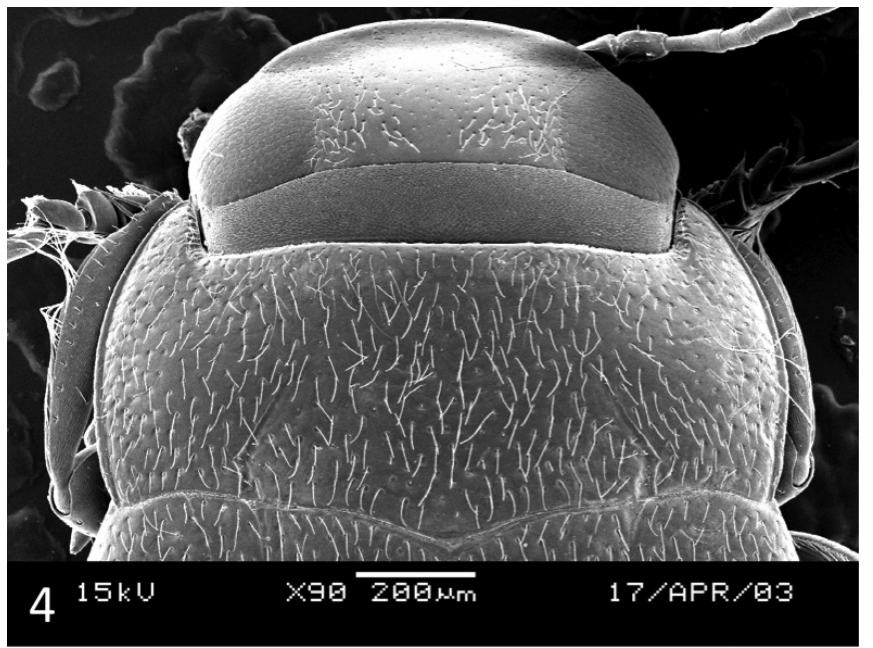
Figure 4. Leiodytes kualalipis sp. n.: male paratype, SEM of head, pronotum and base of elytra.